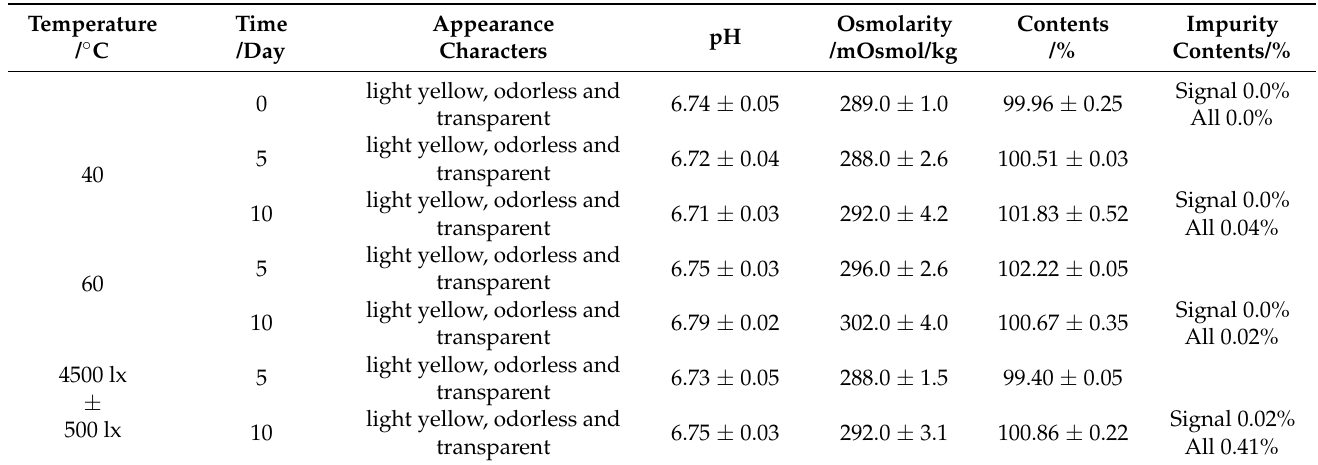
Table 3. Stability of BRT-ISG under 40 ◦ C, 60 ◦ C and high light ( n = 3).